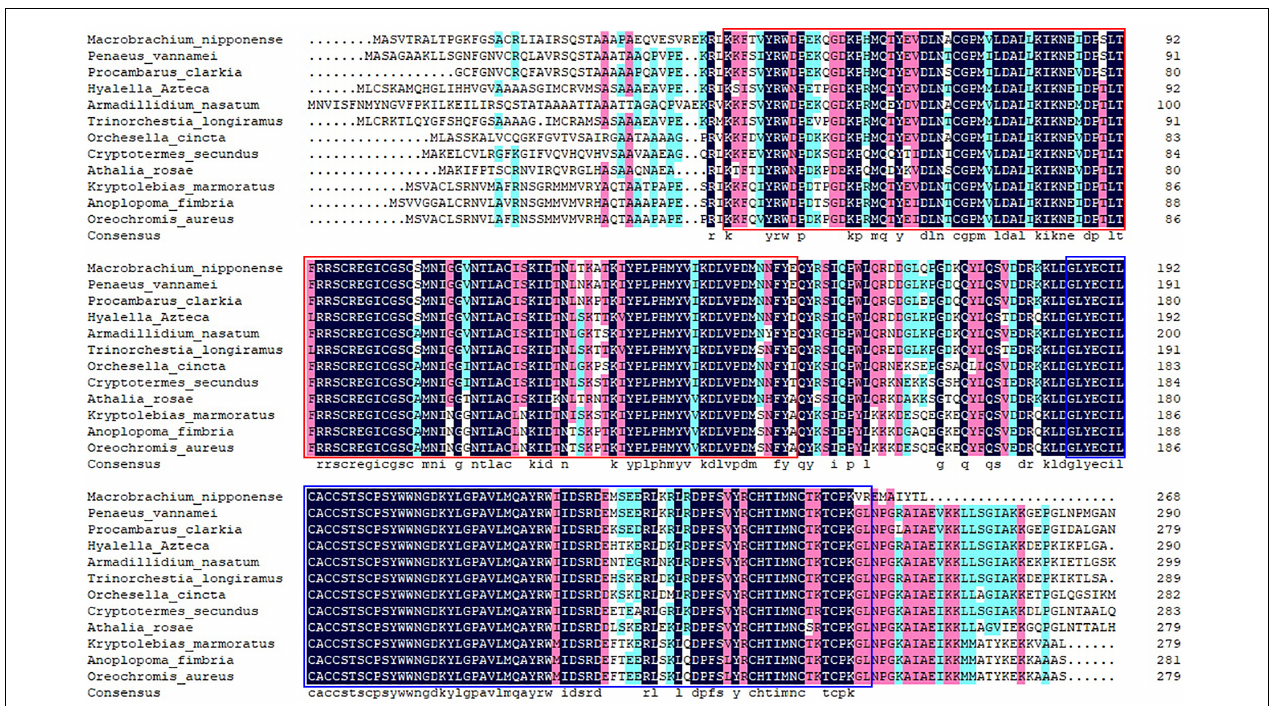
FIGURE 2 | The similarity identity of amino acid sequences of SDHB between different species. Red box indicates the 2Fe–2S iron–sulfur cluster binding domain. Blue box indicates the 4Fe–4S dicluster